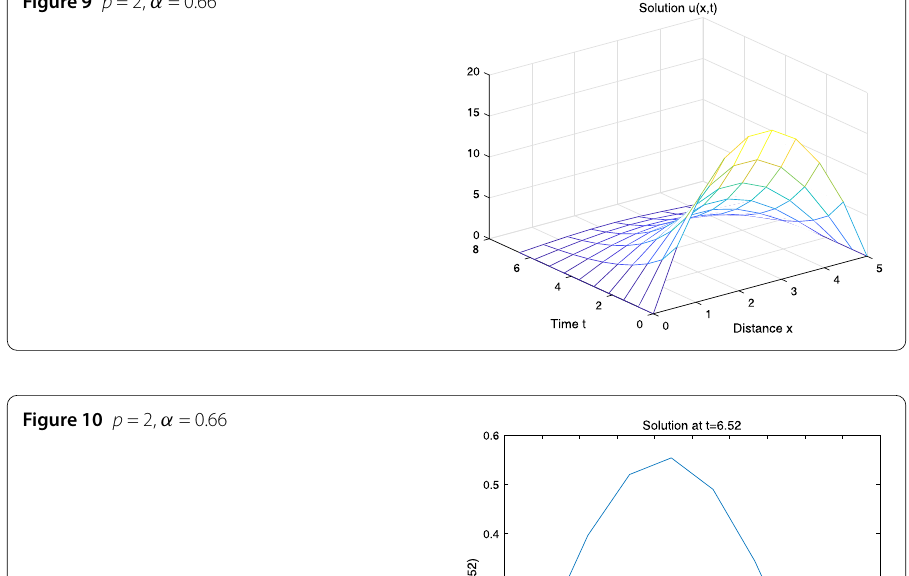
Figure 10 p = 2, α = 0.66